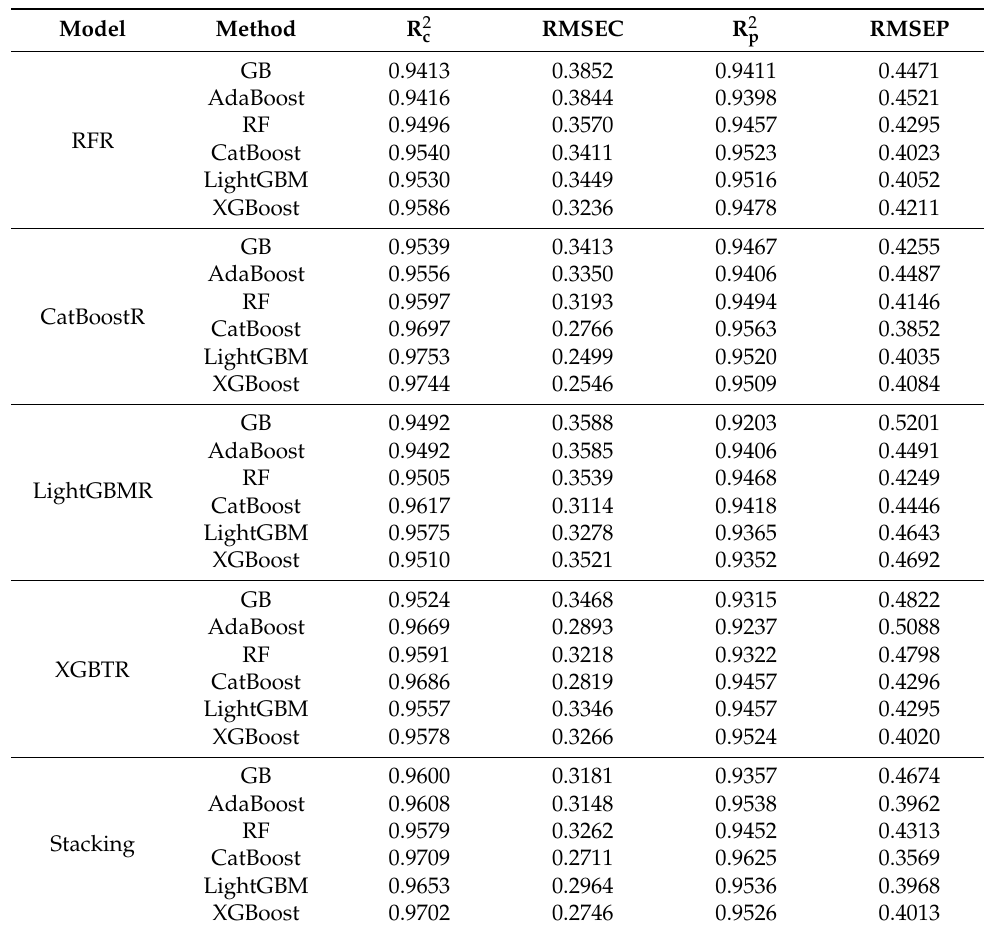
Table 3. Predictive performance of models using the characteristic wavelengths extracted by different